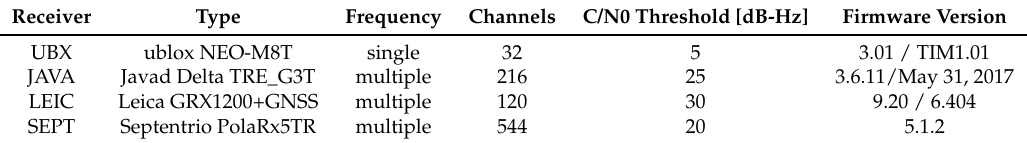
Table 1. Geodetic and consumer market receiver used in in a zero baseline set-up for benchmark